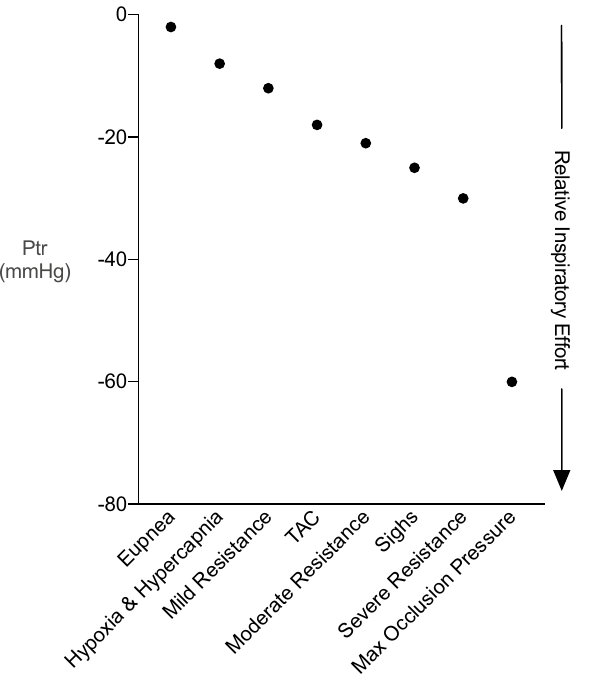
Figure 8. Inspiratory tracheal pressure for various respiratory efforts in rats. Representative tracheal pressure values expected across a range of cardiorespiratory conditions. Ptr Tracheal pressure, TAC Transverse-aortic constriction to induce pressure-overload heart